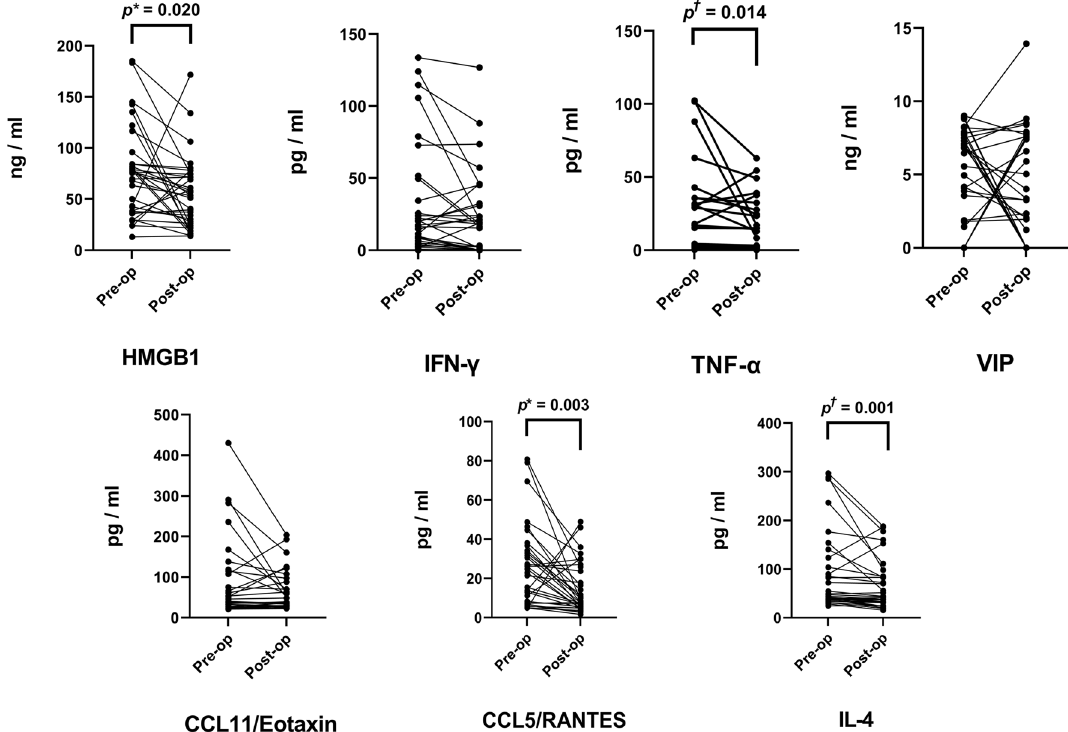
Figure 4. Changes in inflammatory biomarker concentration in the nasal secretion after septoplasty. Changes of each biomarker concentration in the nasal secretion after septoplasty in 34 paired nasal cavities are demonstrated. Each dot represents the measured biomarker concentration in each nasal cavity. A paired t -test or Wilcoxon signed-rank test was used to evaluate the significant differences in each cytokine concentration between the pre- and postoperative state depending on the normal distribution of the measured biomarker concentration. The upper asterisk indicates statistical significance by using the paired t-test ( p value < 0.05). The upper dagger indicates statistical significance by using the Wilcoxon signed-rank test ( p value <